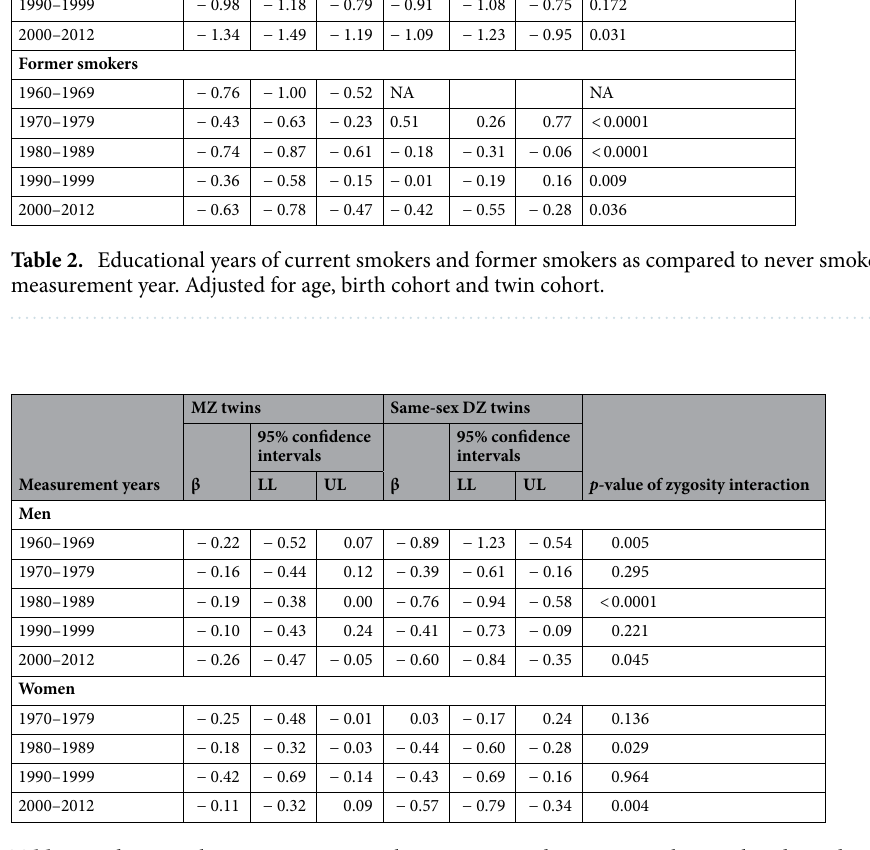
Table 3. Educational years in current smokers as compared to never smokers within discordant twin pairs by measurement year, zygosity and sex.